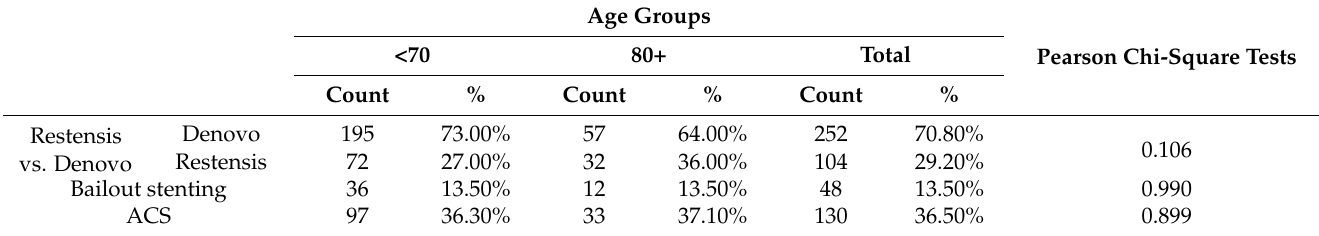
Table 2. Procedural